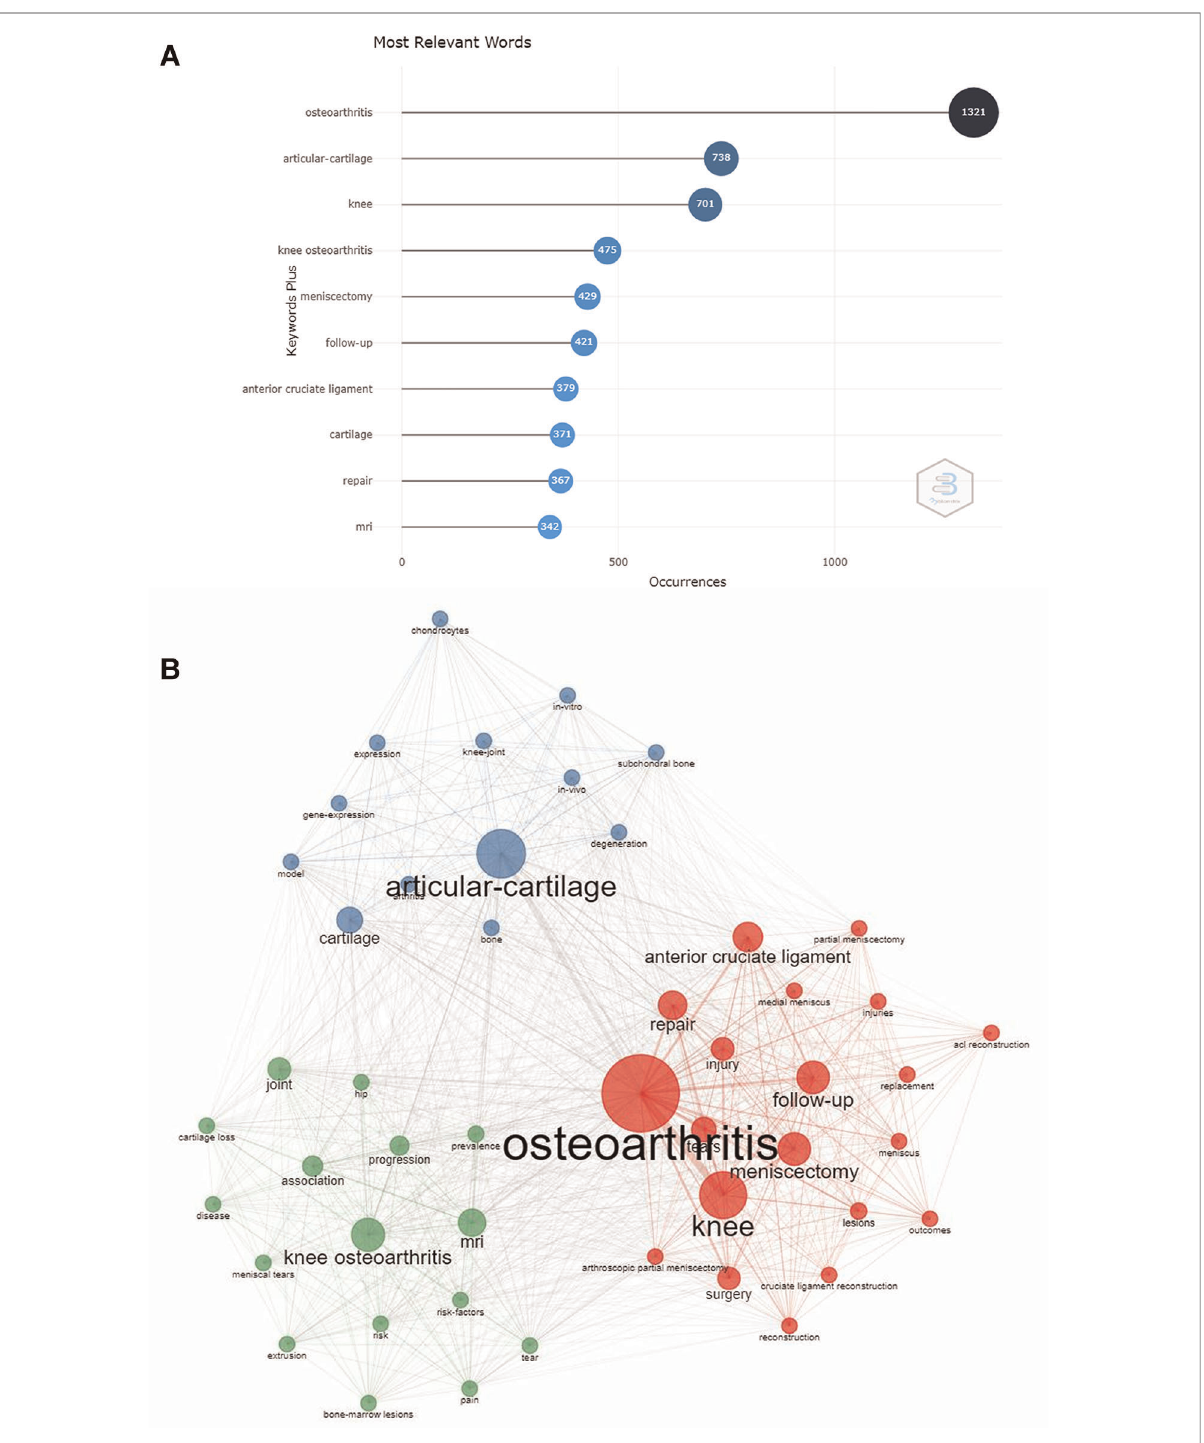
FIGURE 6 ( A ) Keywords based on 20-year publications. ( B ) The visualization map of popular